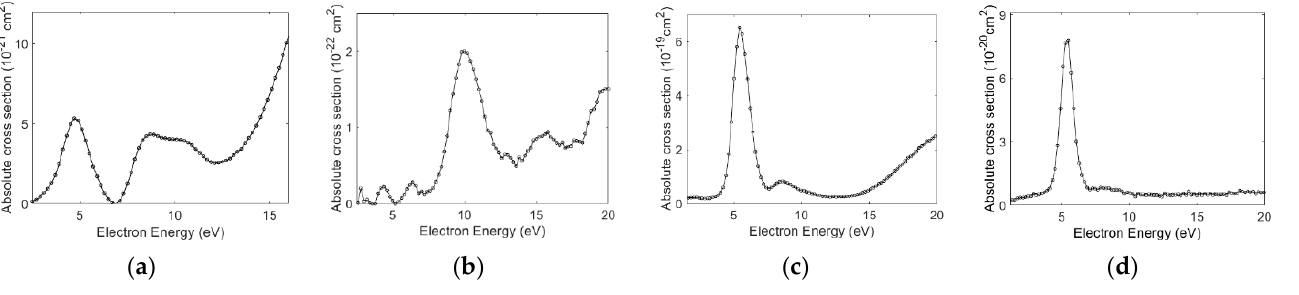
Figure 1. DEA absolute cross-sections measured for ( a ) H − and ( b ) CN − channels from aniline and ( c ) H − and ( d ) CN − channels from benzylamine as a function of electron